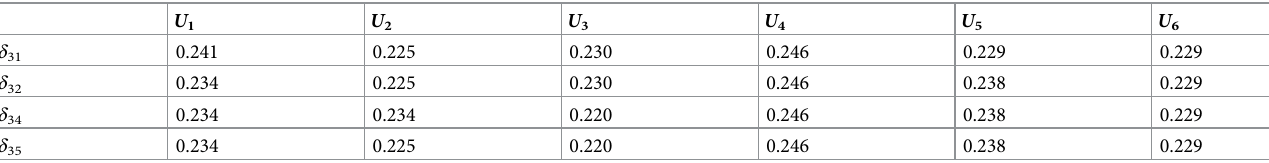
Table 11. The transformed probability of alternative O 3 to others.